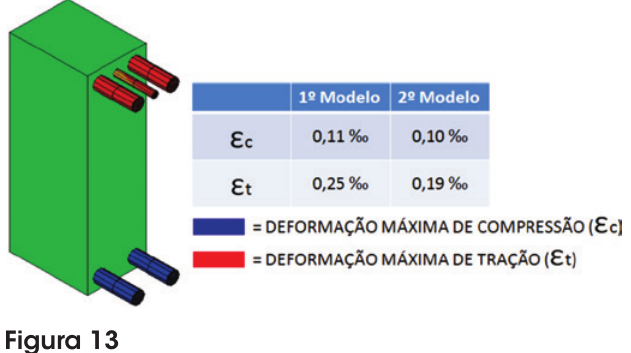
Figura 13 Deformações no aço na seção de momento máximo